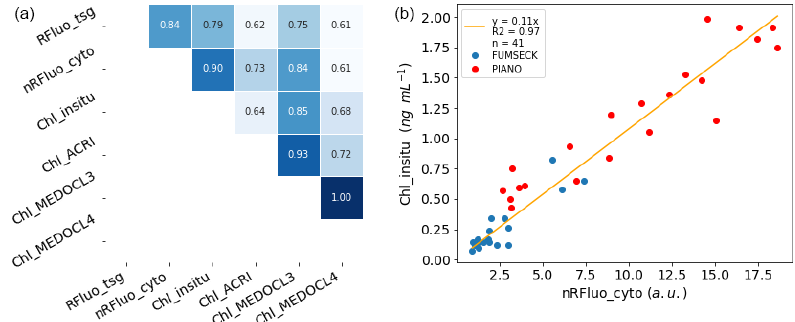
Figure 2. Panel (a) shows a correlation plot between different sources of fluorescence and Chl- a concentration estimation per unit volume: fluorescence from the flow-through fluorometer (Rfluo_tsg, a.u., n = 8385); the sum of all phytoplankton cells’ normalised red fluorescence from the CytoSense (nRFluo_cyto, a . umL − 1 , n = 400); and Chl a from in situ discrete sampling (Chl_insitu, ngmL − 1 , n = 20), from the ACRI ocean colour product for 06:00–18:00UTC during daytime (Chl_ACRI, ngmL − 1 , n = 3522), from the MEDOCL3 product for 06:00–18:00UTC during daytime (Chl_MEDOCL3, ngmL − 1 , n = 2094), and from the MEDOCL4 product for 06:00–18:00UTC during daytime (Chl_MEDOCL4, ngmL − 1 , n = 4498). All of the presented correlations were significant at the 0.01 level using a Pearson test. Panel (b) shows a linear regression between the Chl- a concentration from in situ discrete sampling (Chl_insitu, ngmL − 1 , n = 41) and the sum of all phytoplankton cells’ normalised red fluorescence from the CytoSense (nRFluo_cyto, a . umL − 1 ). Two data sets are shown using the same instrument (PIANO, “Réaction fonctionnelle, structurelle et journalière des organismes du pico- au nanophytoplancton”, and FUMSECK). The intercept coefficient of the regression was not significant at the 10% level ( t test).